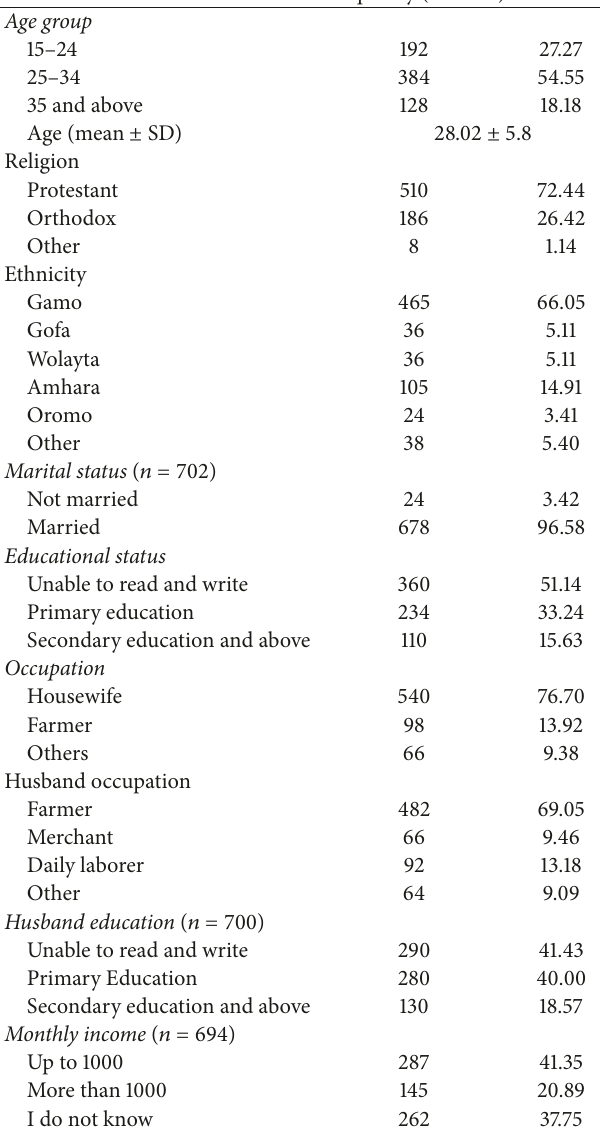
Table 1: Sociodemographic characteristics of participants Arba Minch Zuria District, Ethiopia, March, 2017.